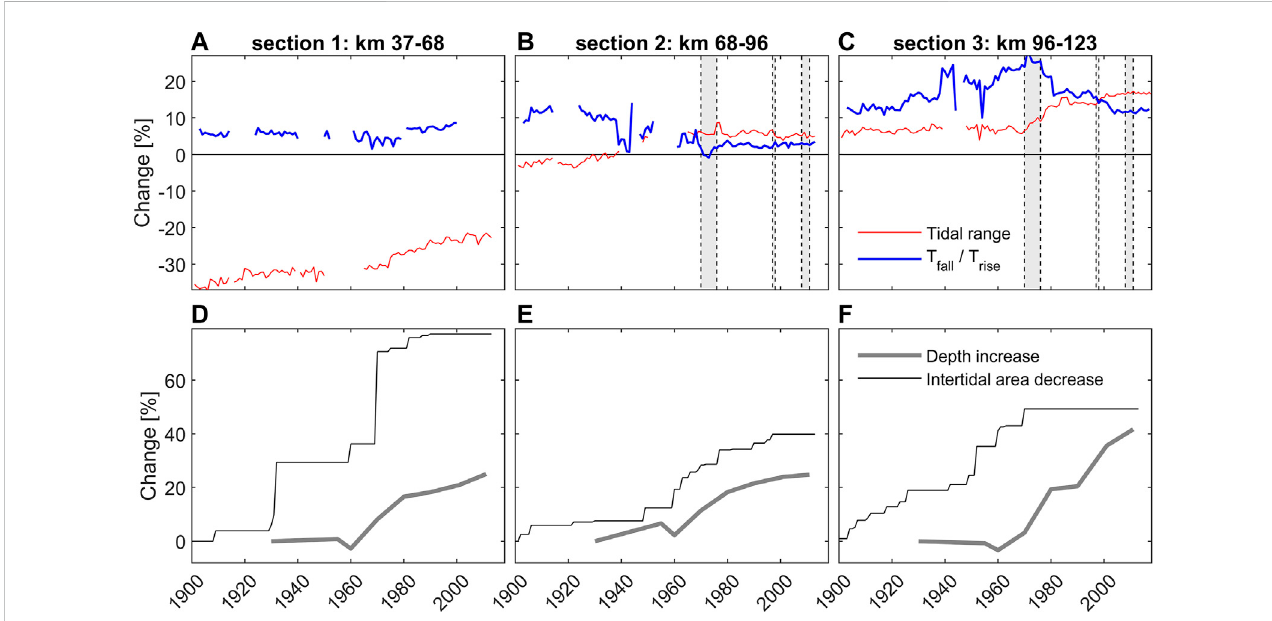
FIGURE 6 Changeintidalrangeanddurationasymmetry (A – C) andindepthandintertidalarea (D – F) forthreesectionsintheSeaScheldt.Thechangeintidalrange (or ratio of falling tide to rising tide) is de fi ned as the percentual increase of the tidal range (or ratio of falling tide to rising tide) in the landward direction per section. The change in depth is the average increase in the water depth per section below low water relative to the water depth in 1930. The change in intertidalareaisthereductionofintertidalareabylandreclamation(i.e.,notresultingfrommorphologicalchangesoftheseareas)relativetotheintertidal areapresentin1900(i.e.a70%changeimpliesthat30%oftheoriginalintertidalarearemains).Thesectionbetweenkm37 – 68(Dendermonde – Schelle)ispart of the upper Sea Scheldt where no deepening took place. The section betweenkm 68 – 96 (Liefkenshoek – Schelle) is the lower Sea Scheldt including the port ofAntwerp.Thesectionbetweenkm96 – 123(Liefkenshoek – Hansweert)isthetransitionbetweentheWesternScheldtestuaryandthelowerSeaScheldt.The waterdepthandintertidal areadataisfromVandenbruwaeneetal.(2019b);seereferencesinFigure5fororiginofthetidaldata.Thegreyshadedbarsinpanel (B) and (C) indicate periods of capital